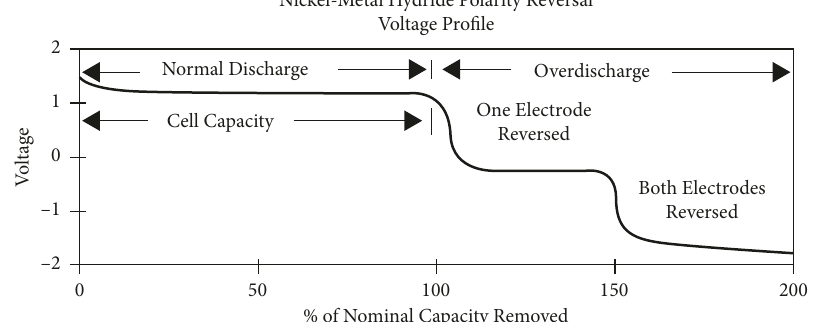
Figure 5: Ni-metal polarity reversal voltage